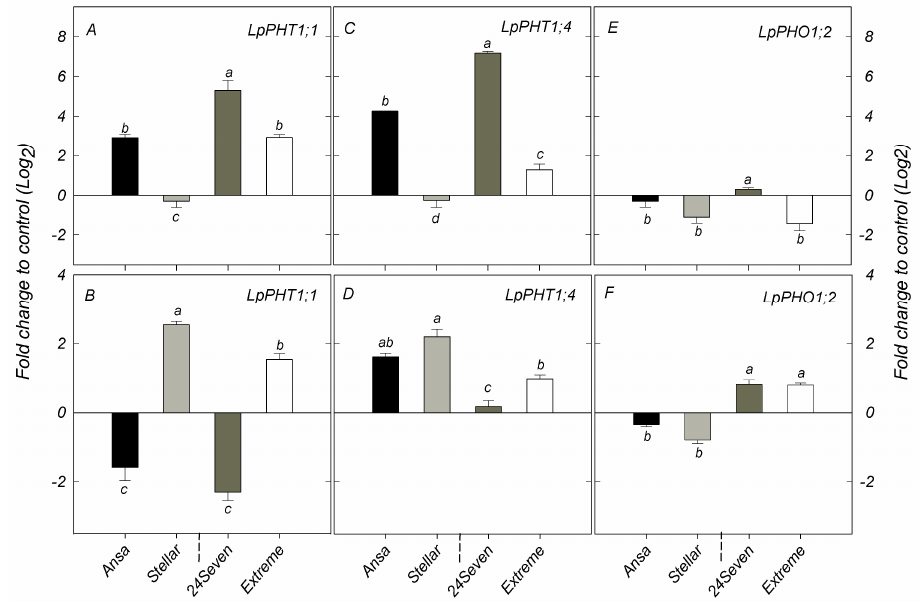
Figure 3. Expression analysis of phosphate transporters LpPHT1;1 ( A , B ); LpPHT1;4 ( C , D ); and LpPHO1;2 ( E , F ) genes determined by qRT-PCR in shoots and roots of ryegrass cultivars hydroponically grown at optimal (0.1 mM P) and deficient (0.01 mM P) P conditions. All data were normalized to geometric mean value from LpeEF1α(h) and LpeEF1α(s) housekeeping genes and expressed as fold change of control treatment (0.1 mM P). Log2 was performed to better understand the regulation of these genes. Values represent the mean (n = 3) ± standard error. Different letters indicate statistically significant differences (Tukey’s HSD at p ≤ 0.05) between cultivars.